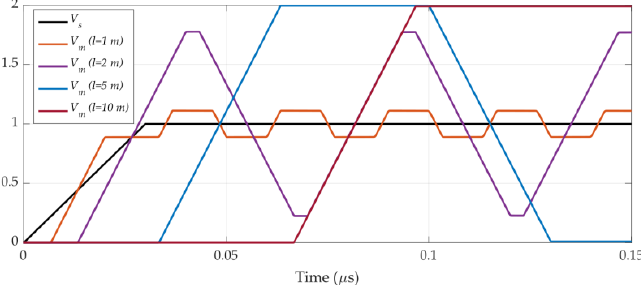
Figure 4. The first 0.15 μs of voltage waveforms at motor terminals ( 𝑉 𝑚 ) when the motor is fed by a step voltage with 𝑡 𝑟 = 30 ns. step voltage with t r = 30 ns.